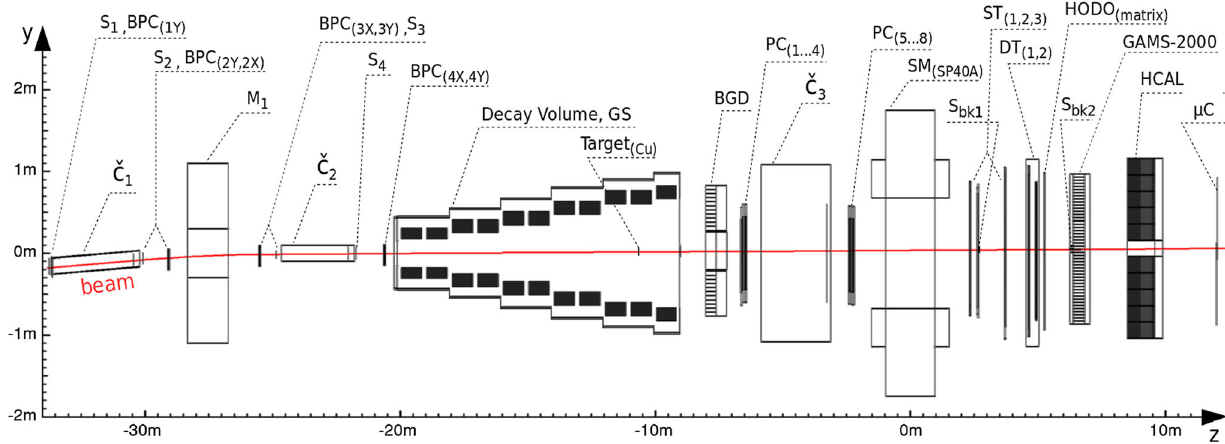
Fig. 1 Schematic elevation view of the OKA setup, reproduced from [13], see the text for details two gas threshold Cherenkov counters ˇC 1 , ˇC 2 for kaon identi- fication and by beam scintillation counters S 1 , S 2 , S 3 , S 4 . The 11 m long Decay Volume (DV) filled with helium contains 11 rings of guard system (GS). To reinforce GS, a gamma detec- tor (BGD), made of lead glass blocks located behind the DV is used as a veto at large angles, while low angle particles pass